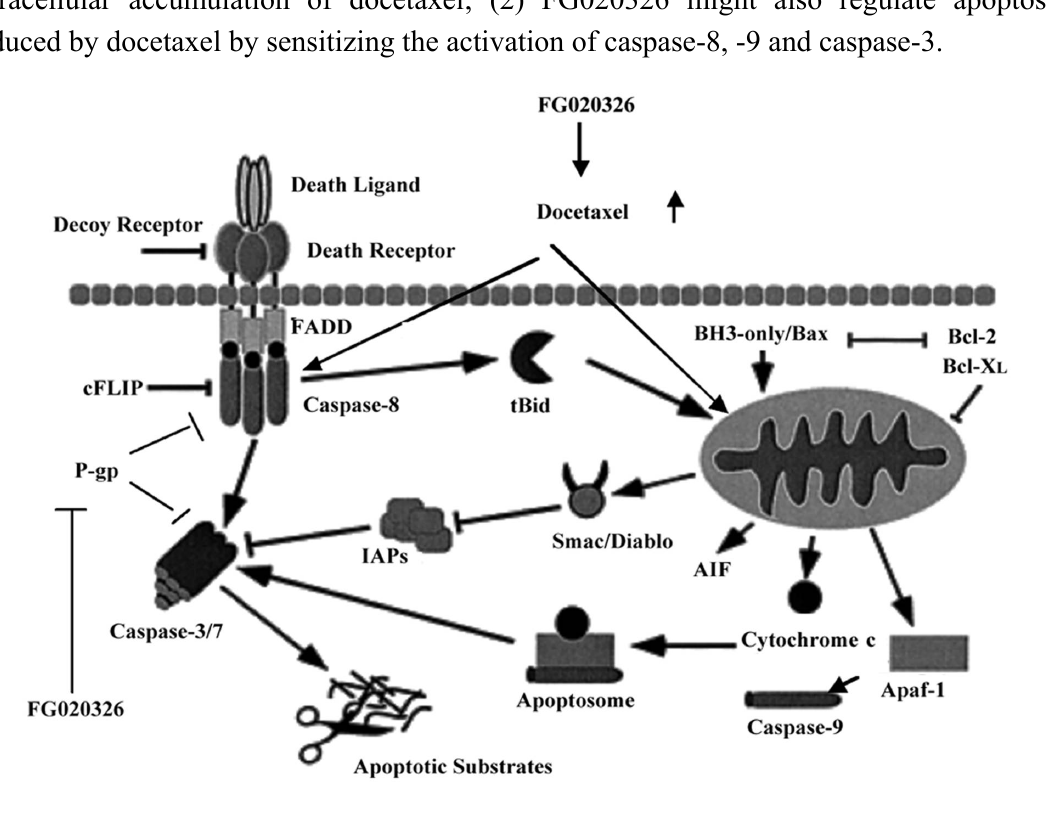
Figure 6. The mechanisms of FG020326 on the reversal of apoptotic resistance. (1) FG020326 could reverse MDR by inhibiting P-gp transporter function and increasing intracellular accumulation of docetaxel; (2) FG020326 might also regulate